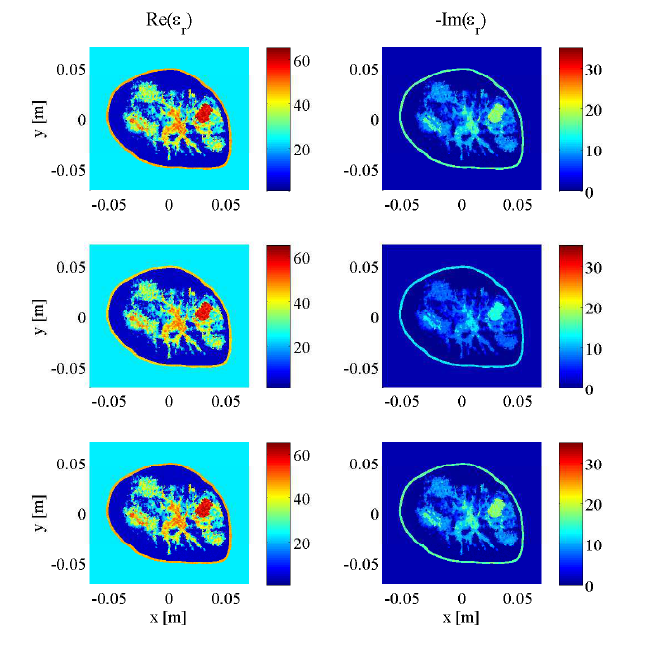
Figure 4. Complex dielectric properties of University of Calgary 2D synthetic breast model at